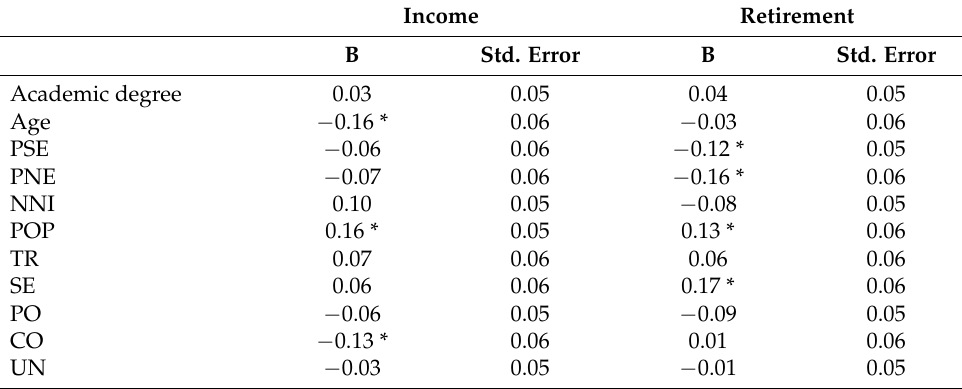
Table 4. MANOVA: Parameter estimates.